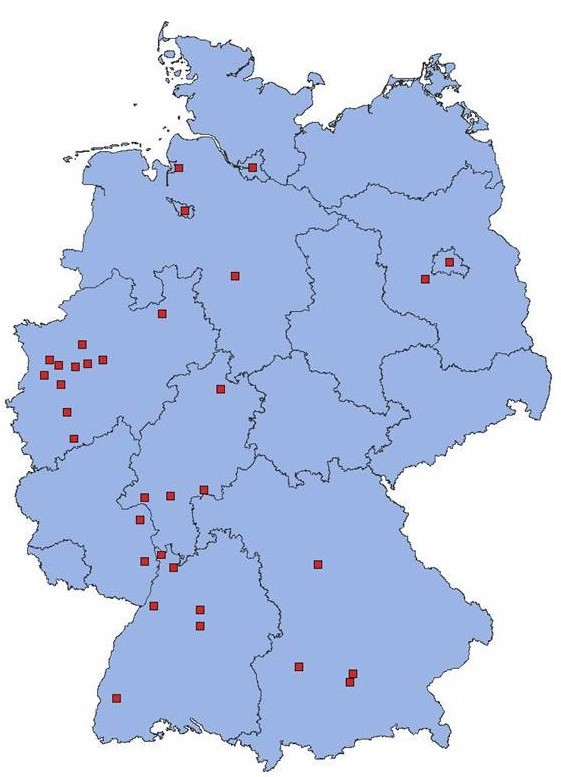
Cities with recruitment sites (map of Germany with federal states). We have the copyright to this file.